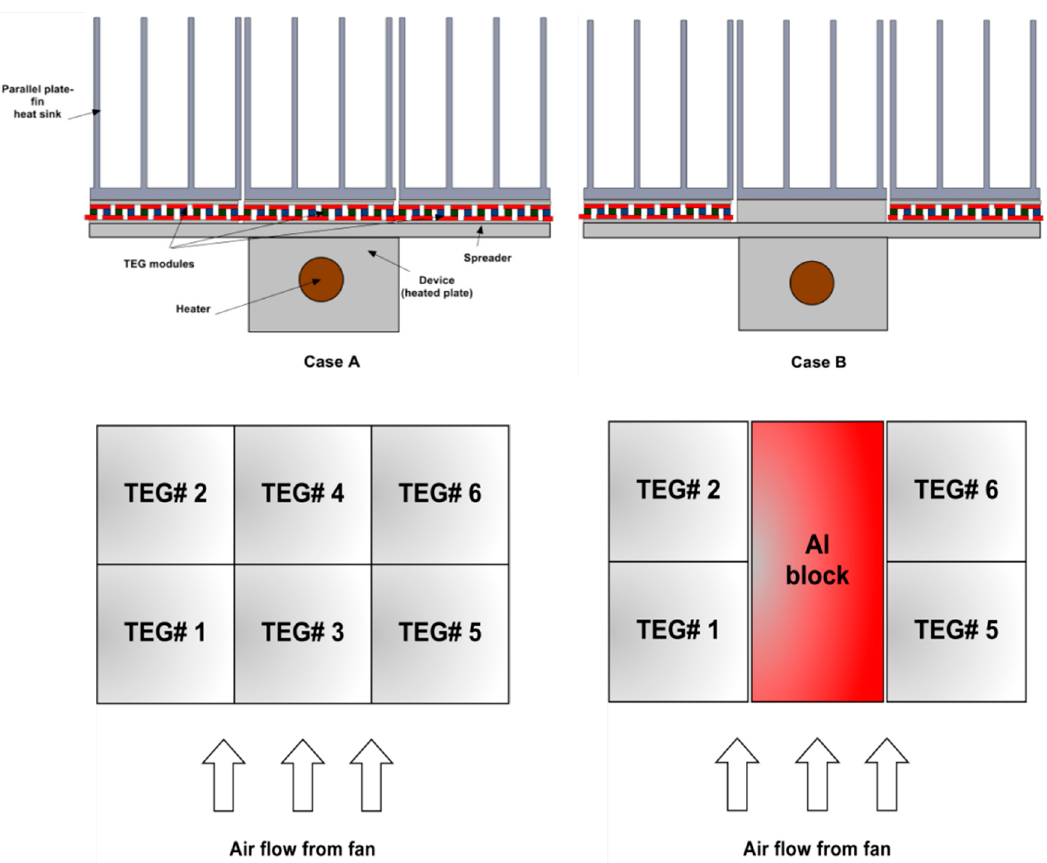
Figure 1. ( a ) Geometrical configuration of the cases A and B ( top ); ( b ) thermoelectric generator (TEG) arrays in case A ( bottom left ); ( c ) TEG arrays and aluminum block in case B ( bottom right ).